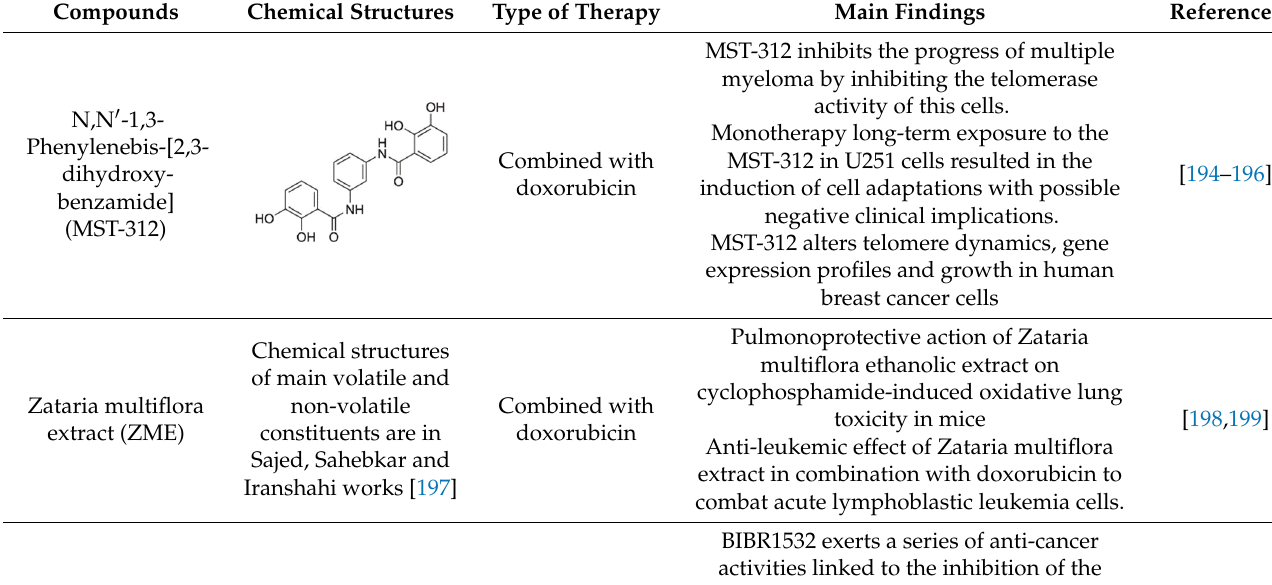
Table 1. Telomerase inhibitors.